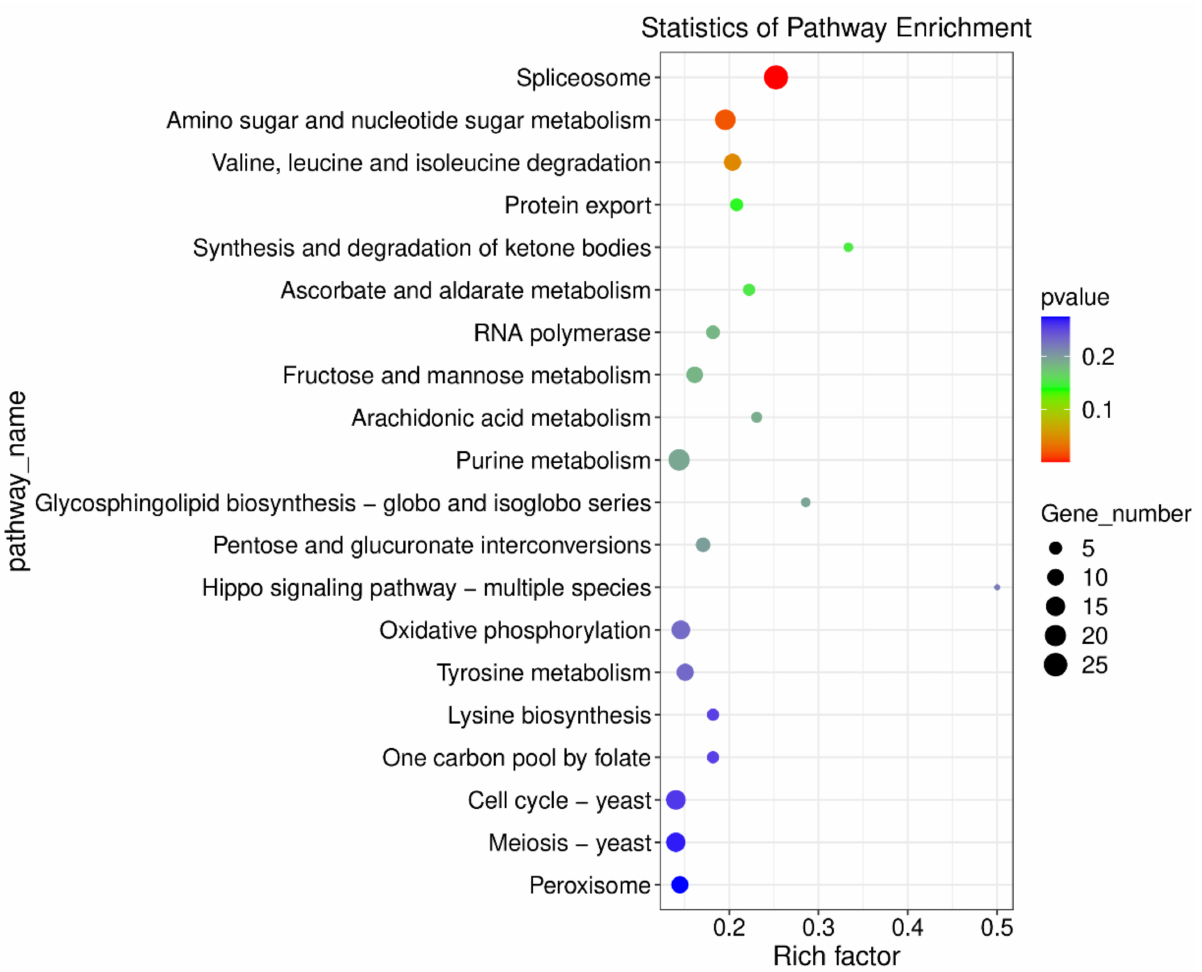
Figure 8. KEGG enrichment scatter plot. The ordinate represents the KEGG pathway, the abscissa represents the Rich factor. The larger the Rich factor, the greater the enrichment. The larger the point, the greater the number of differential genes enriched in the pathway. The redder the color of the dots, the more significant the enrichment.